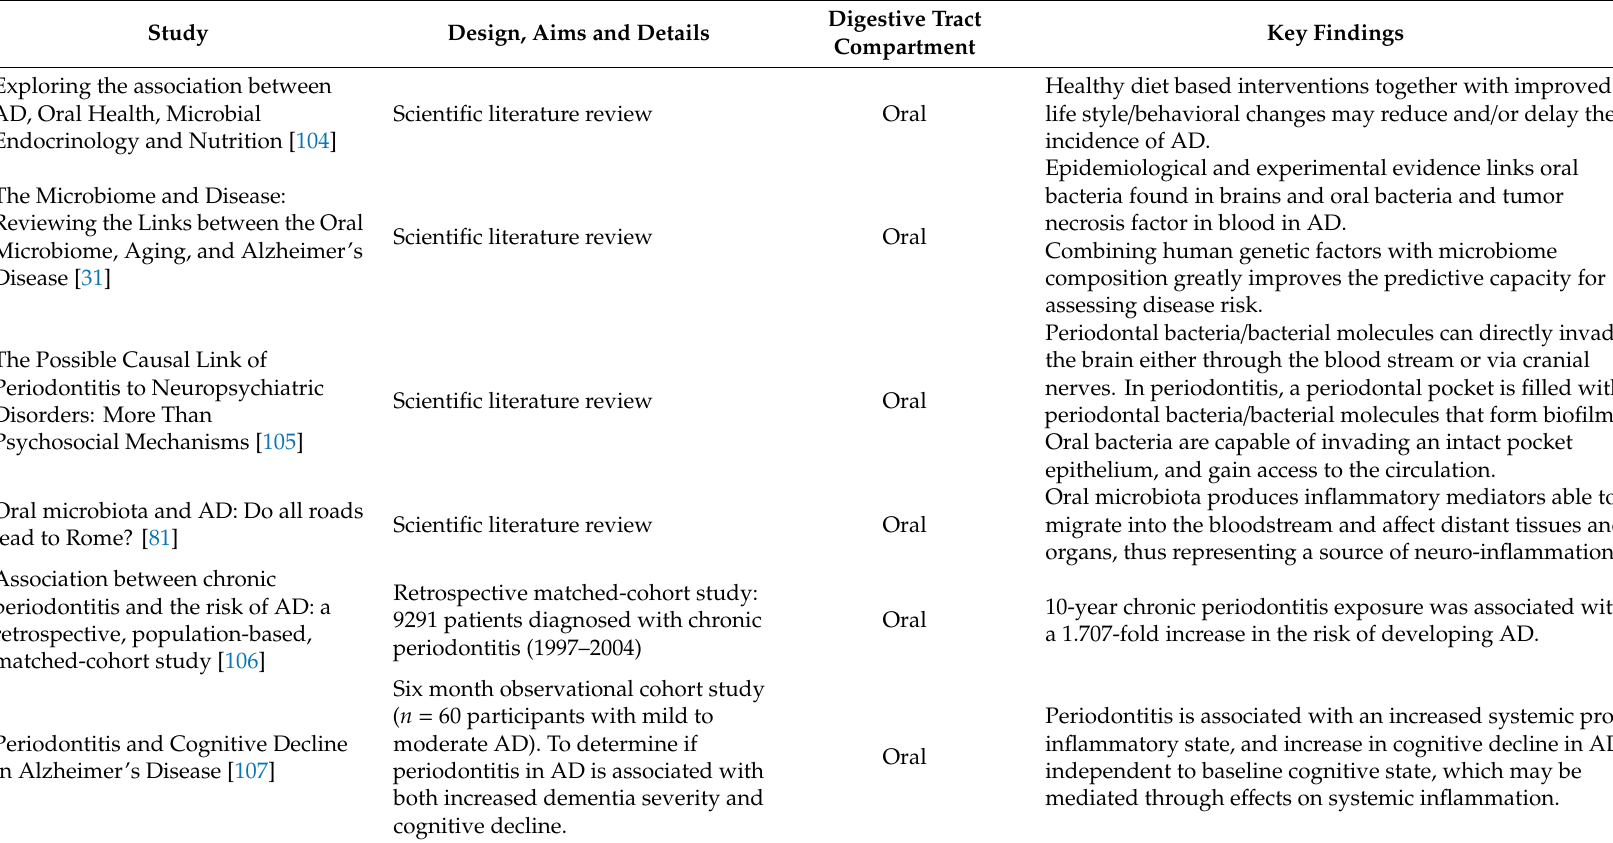
Table 1. Studies associated with alteration of the oral and intestinal microbiota and Alzheimer’s disease